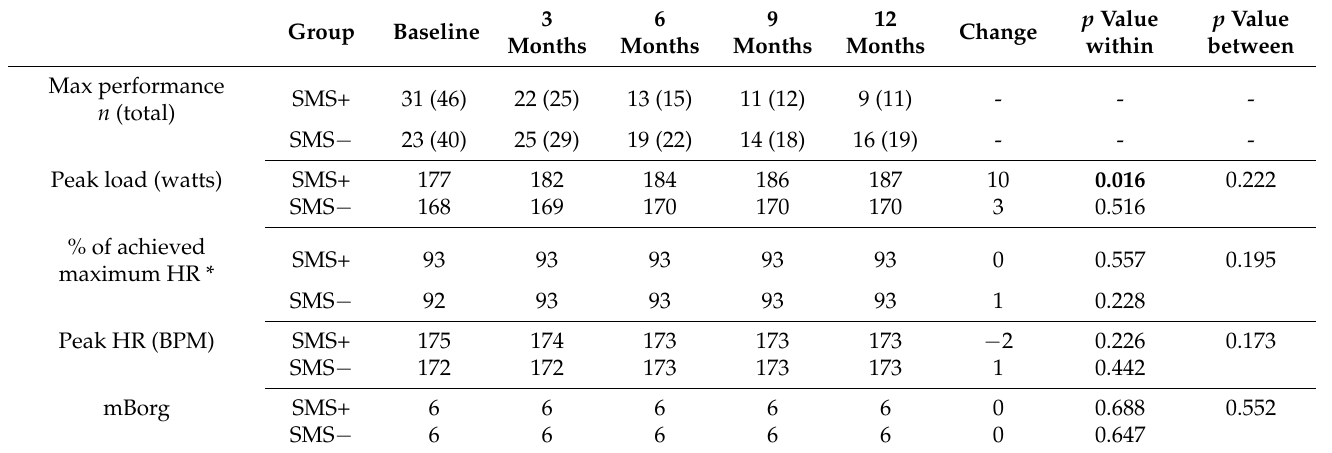
Table 5. Within-group changes in maximal cycle ergometer test outcomes from baseline to 12